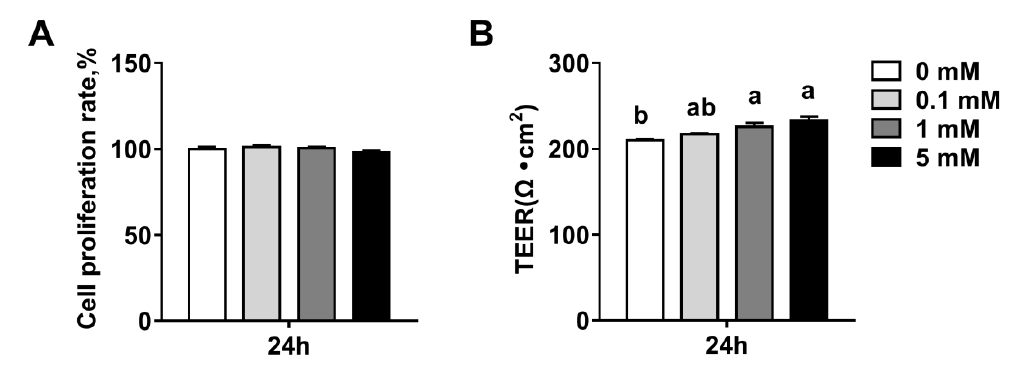
Figure 2. E ff ects of sodium succinate on intestinal permeability in intestinal porcine epithelial cell (IPEC)-J2 cells: ( A ) cell proliferation rate and ( B ) trans-epithelial electrical resistance (TEER). Di ff erent superscript letters indicate significant di ff erences between groups ( p < 0.05).